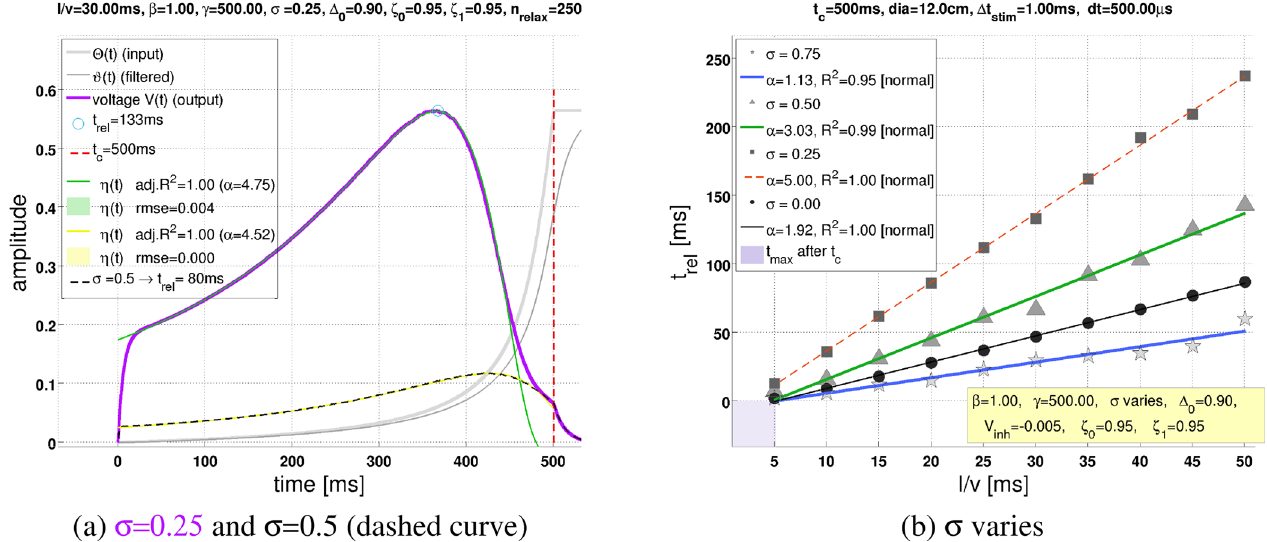
Fig 4. Influence of the inhibitory noise level σ . ( a )The figure illustrates how an increase of the inhibitory noise level from σ = 0.25 to σ = 0.50 moves the maximum of n- ψ towards t c = 500ms, thus t rel (= the remaining time to collision after the peak) decreases from 133ms to 80ms. Furthermore, the amplitude of the n- ψ -response decreases. ( b )The line fits represent the linear dependence of t rel from l / v , where different symbols and line colors, respectively, correspond to different values of σ . The smallest line fit slopes α see Eq (2) were obtained for σ = 0 and σ = 0.75, that is in the absence of inhibitory noise ( α = 1.92) and for the highest tested noise level ( α = 1.13). For the intermediate noise levels σ = 0.25 and σ = 0.50, respectively, the biggest slopes were measured (cf. figure legend; “ normal ” means that the residuals were normal distributed according to a one sample Kolmogorov-Smirnov test).